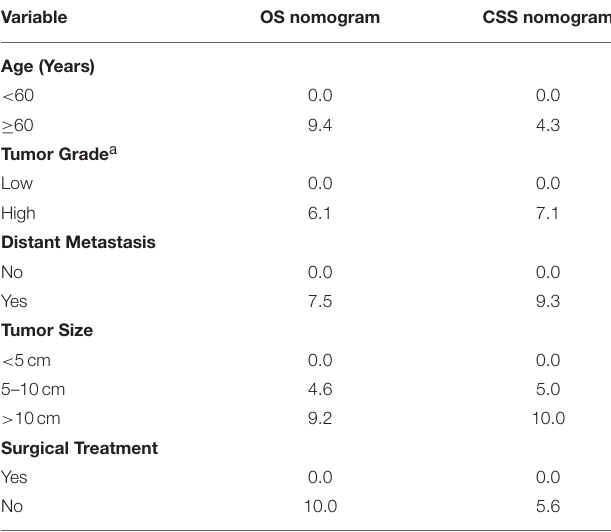
TABLE 4 | Point assignment and prognostic